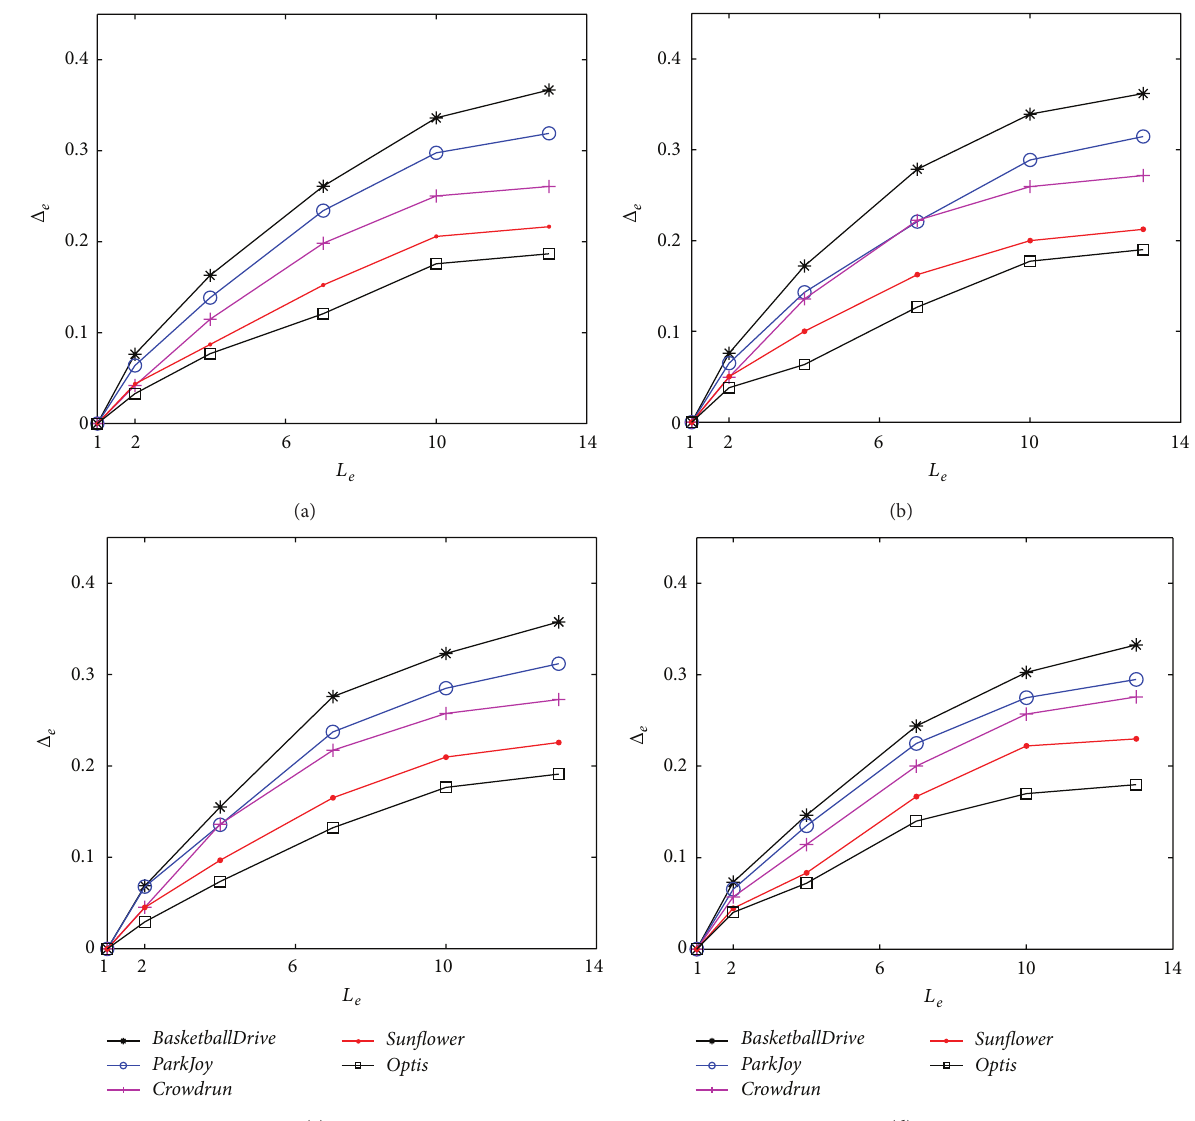
Figure 7: Relationship between length of error propagation and corresponding frame distortion under different QPs. (a) QP = 24, (b) QP = 30, (c) QP = 36, and (d) QP = 42.